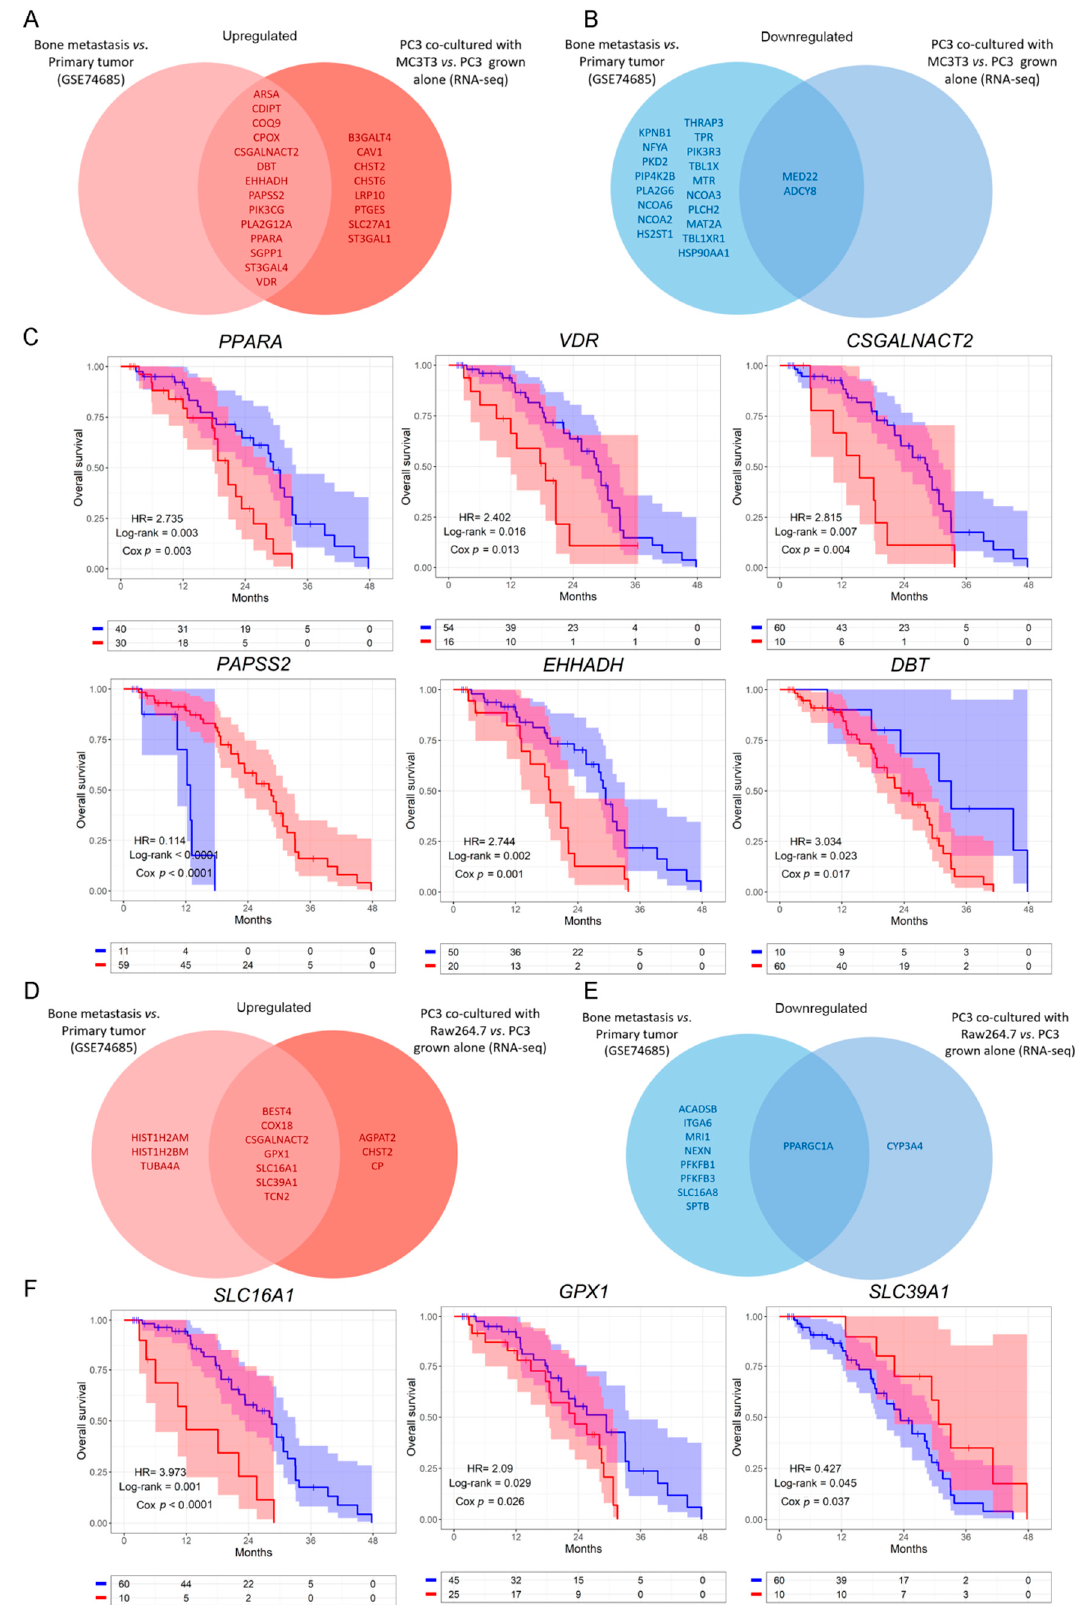
Figure 3. Dysregulated metabolic-related genes in co-cultured PC3 cells compared to PC3 grown alone, and in metastatic compared to primary PCa samples. ( A , B ) Venn diagram showing the upregulated ( A ) or downregulated ( B ) genes obtained from a differential expression analysis